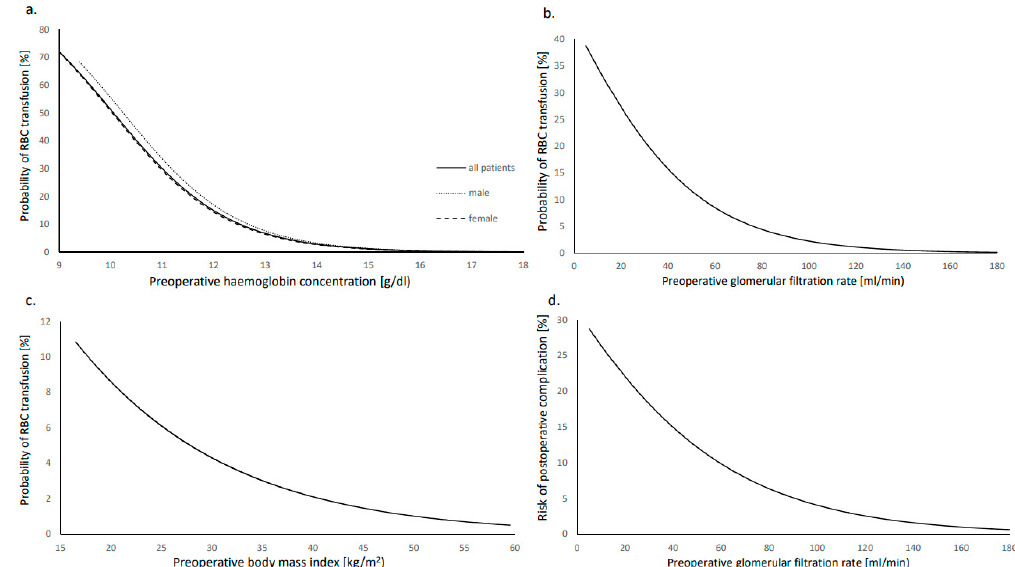
Figure 1. Predicted probabilities of perioperative allogeneic red blood cell (RBC) transfusion with respect to the preoperative haemoglobin concentration ( a ), preoperative estimated glomerular filtration rate (eGFR) ( b ) and preoperative body mass index ( c ). Predicted risks of the occurrence of an acute postoperative complication with respect to the preoperative eGFR ( d ).